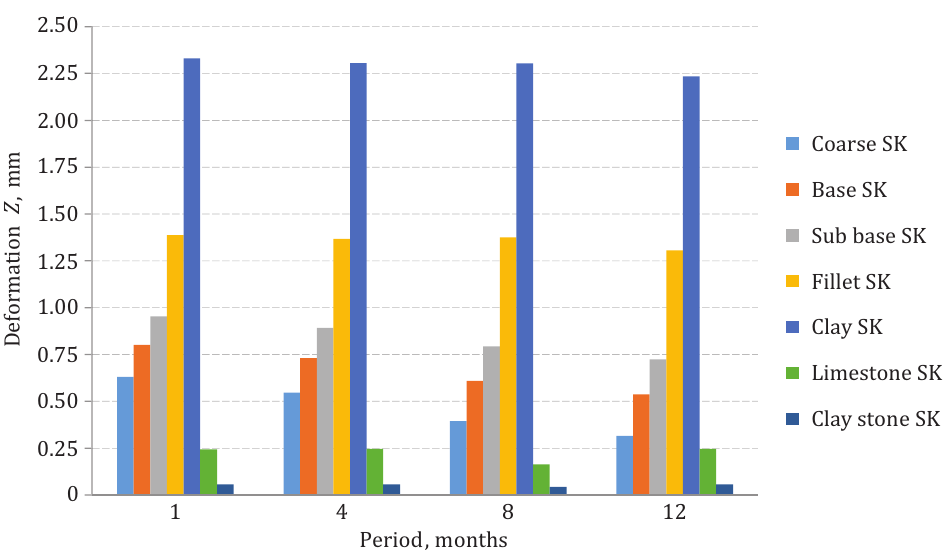
Figure 20. Lateral deformation ( z )-time changes of the layers for SK